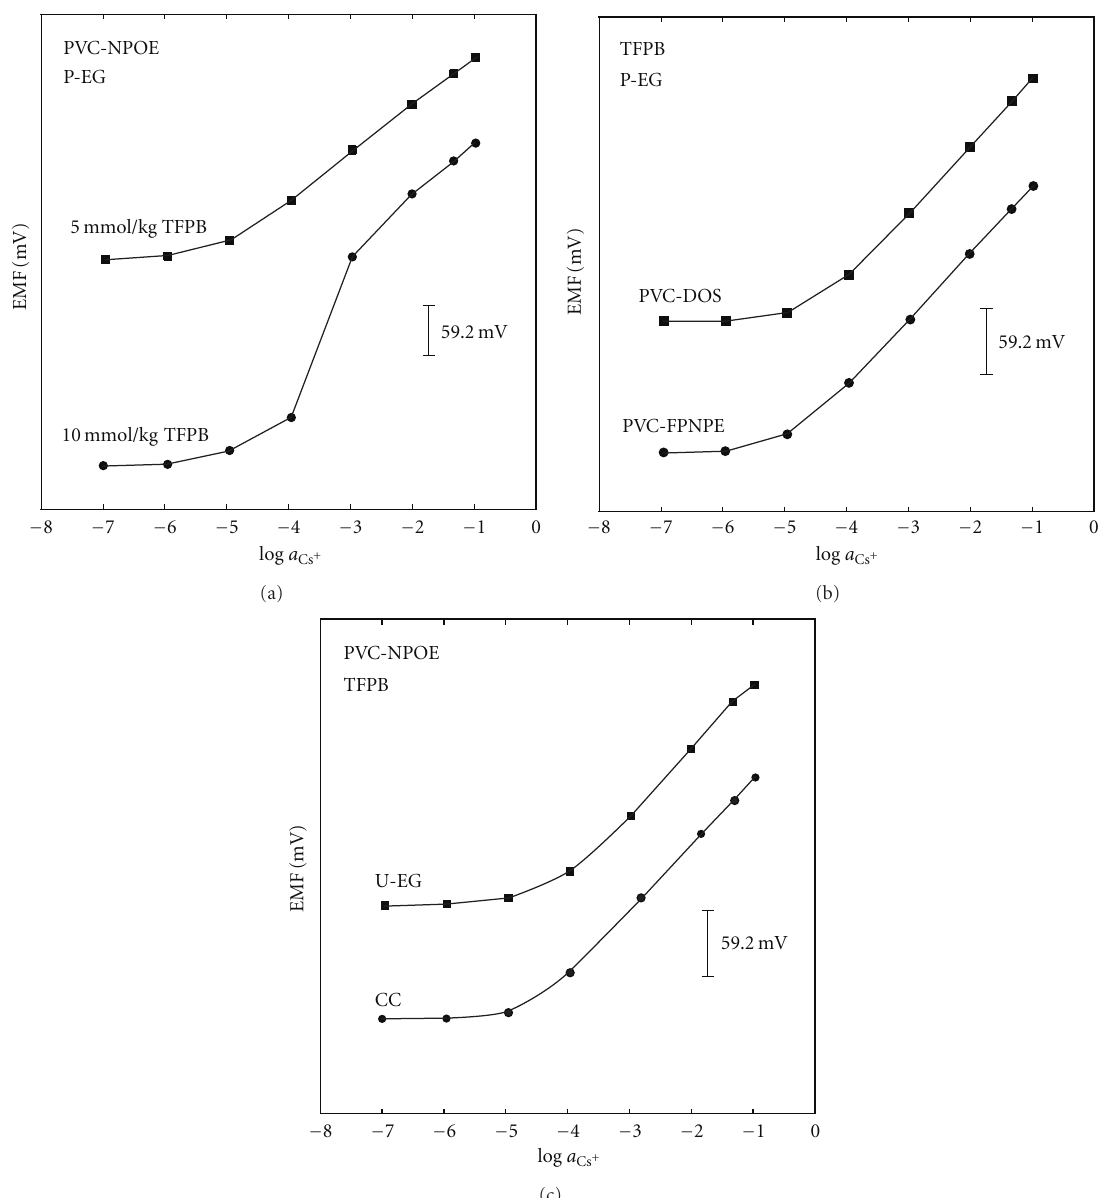
Figure 2: Mean potentiometric response curves of PVC-based Cs + -selective ISEs containing P-EG and TFPB and plasticized with NPOE (a) or either DOS or FPNPE (b). Mean potentiometric response curves of PVC-NPOE membrane containing TFPB and a mobile Cs + ionophore, either U-EG or CC, are also shown for comparison